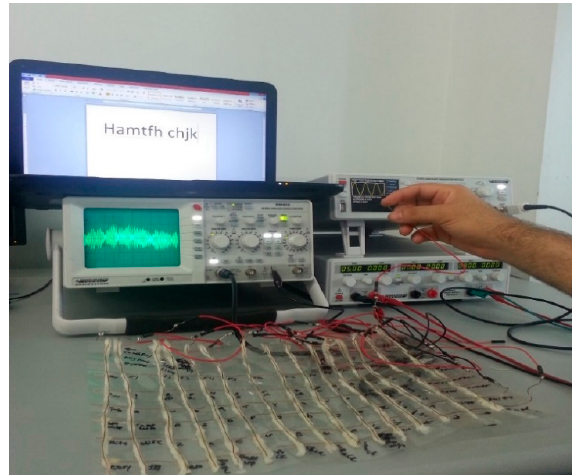
Figure 5. Complete keyboard structure being tested in the laboratory.